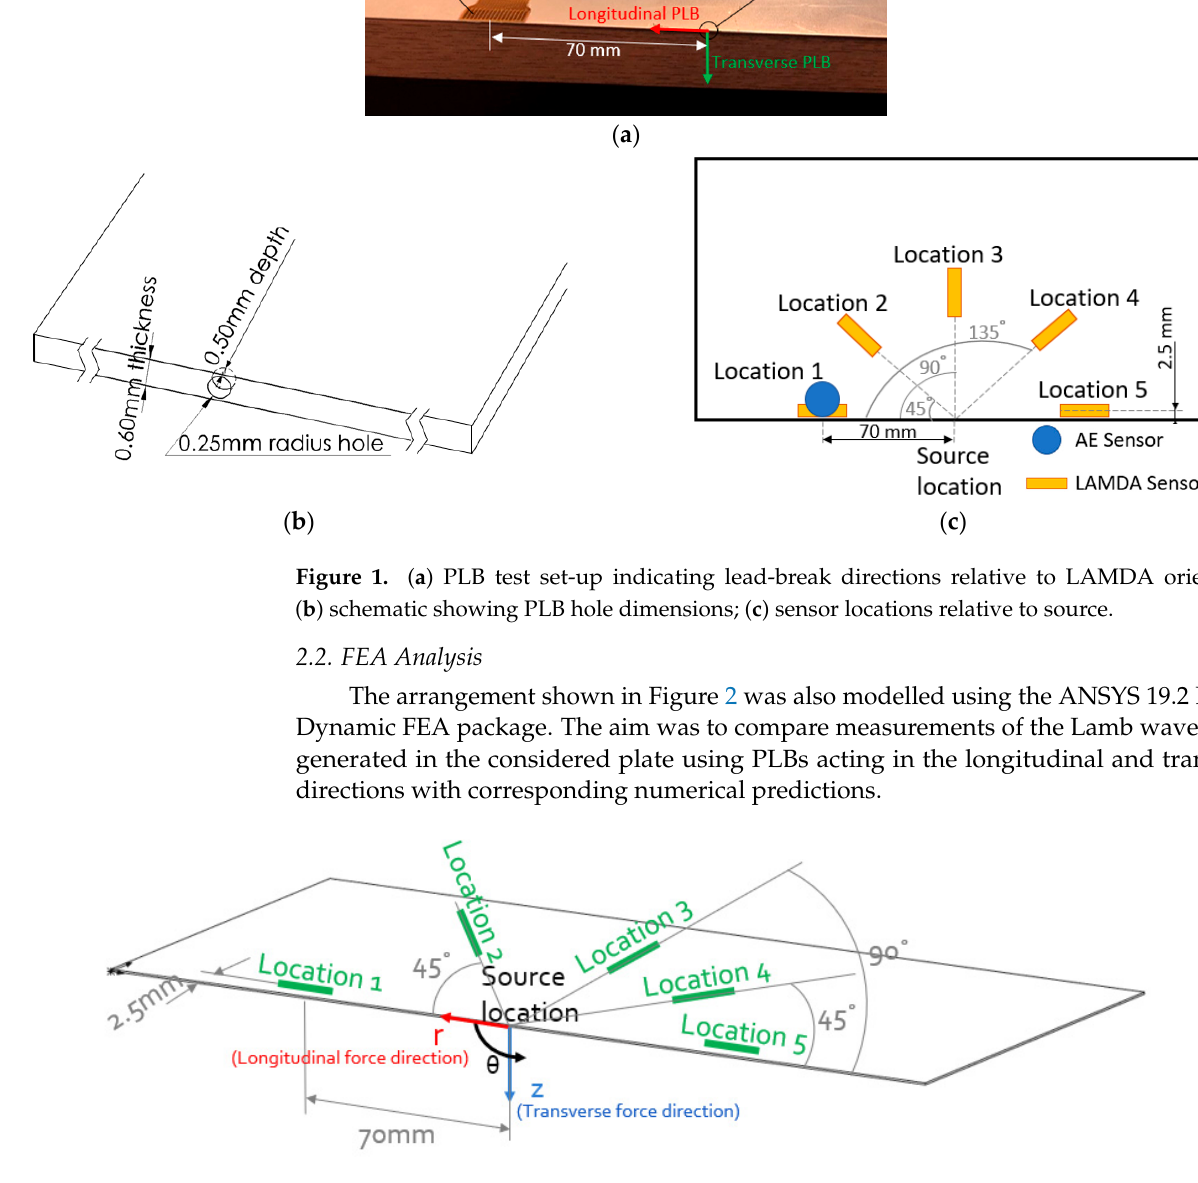
Figure 2. FEA model set up: source position, detecting position, and input force directions.